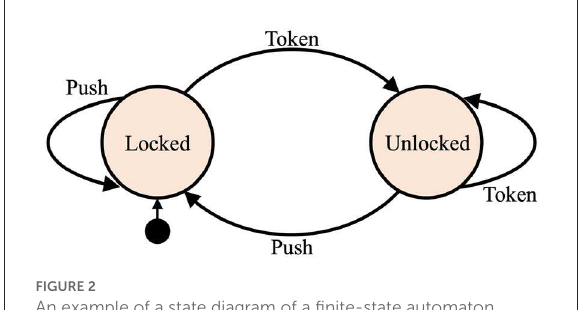
FIGURE2 An example of a state diagram of a finite-state automaton modeling the control logic of a turnstile. It has two states and two possible inputs. The start state is depicted by the arrow pointing from the black